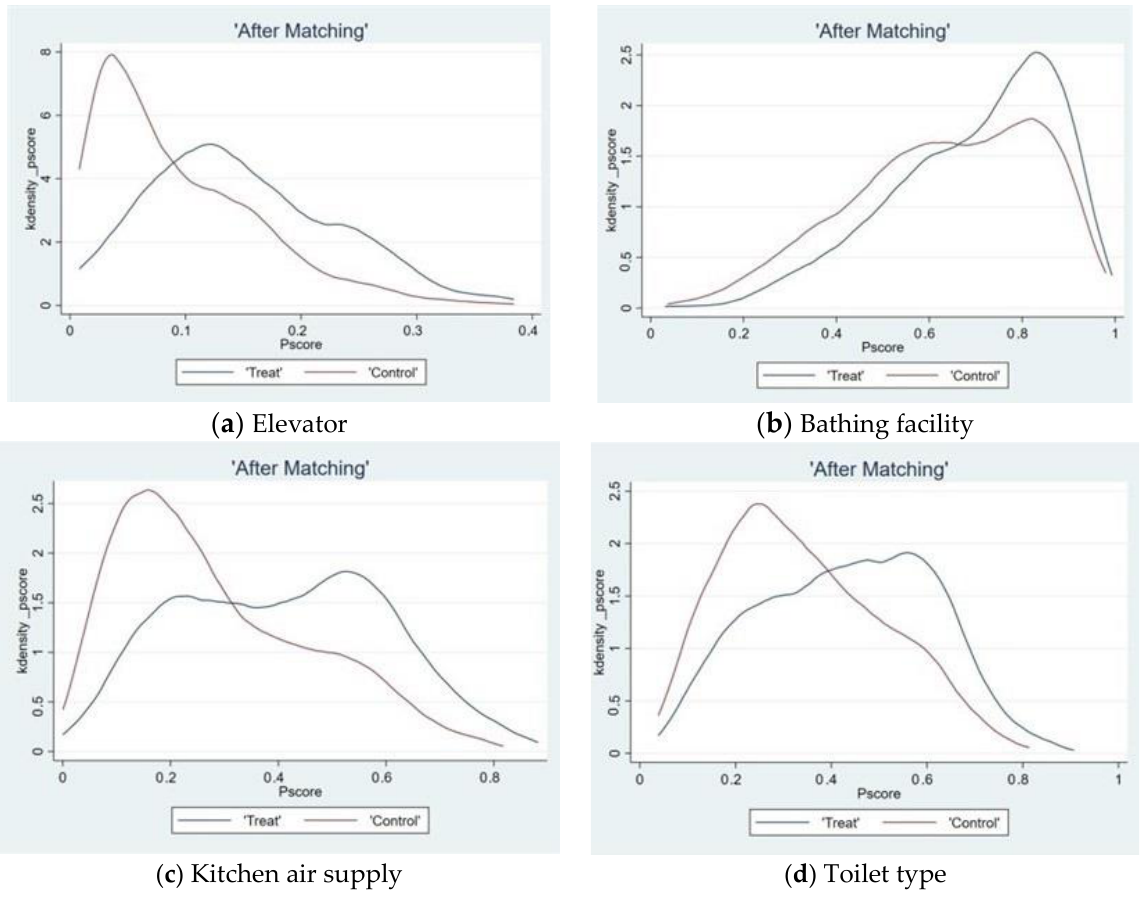
Figure 4. Kernel density.